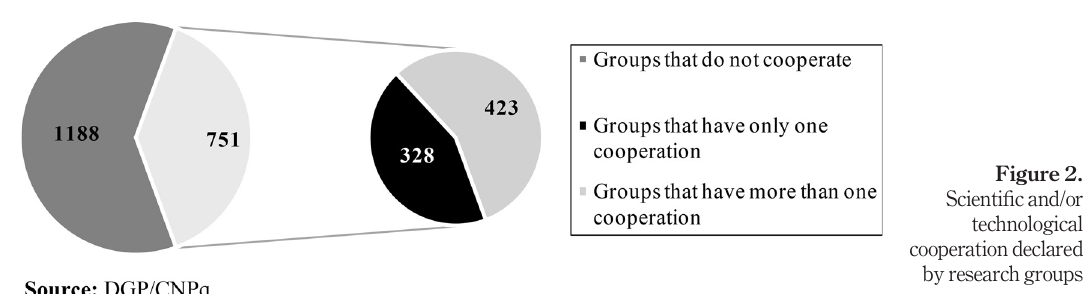
Figure 1. Participation